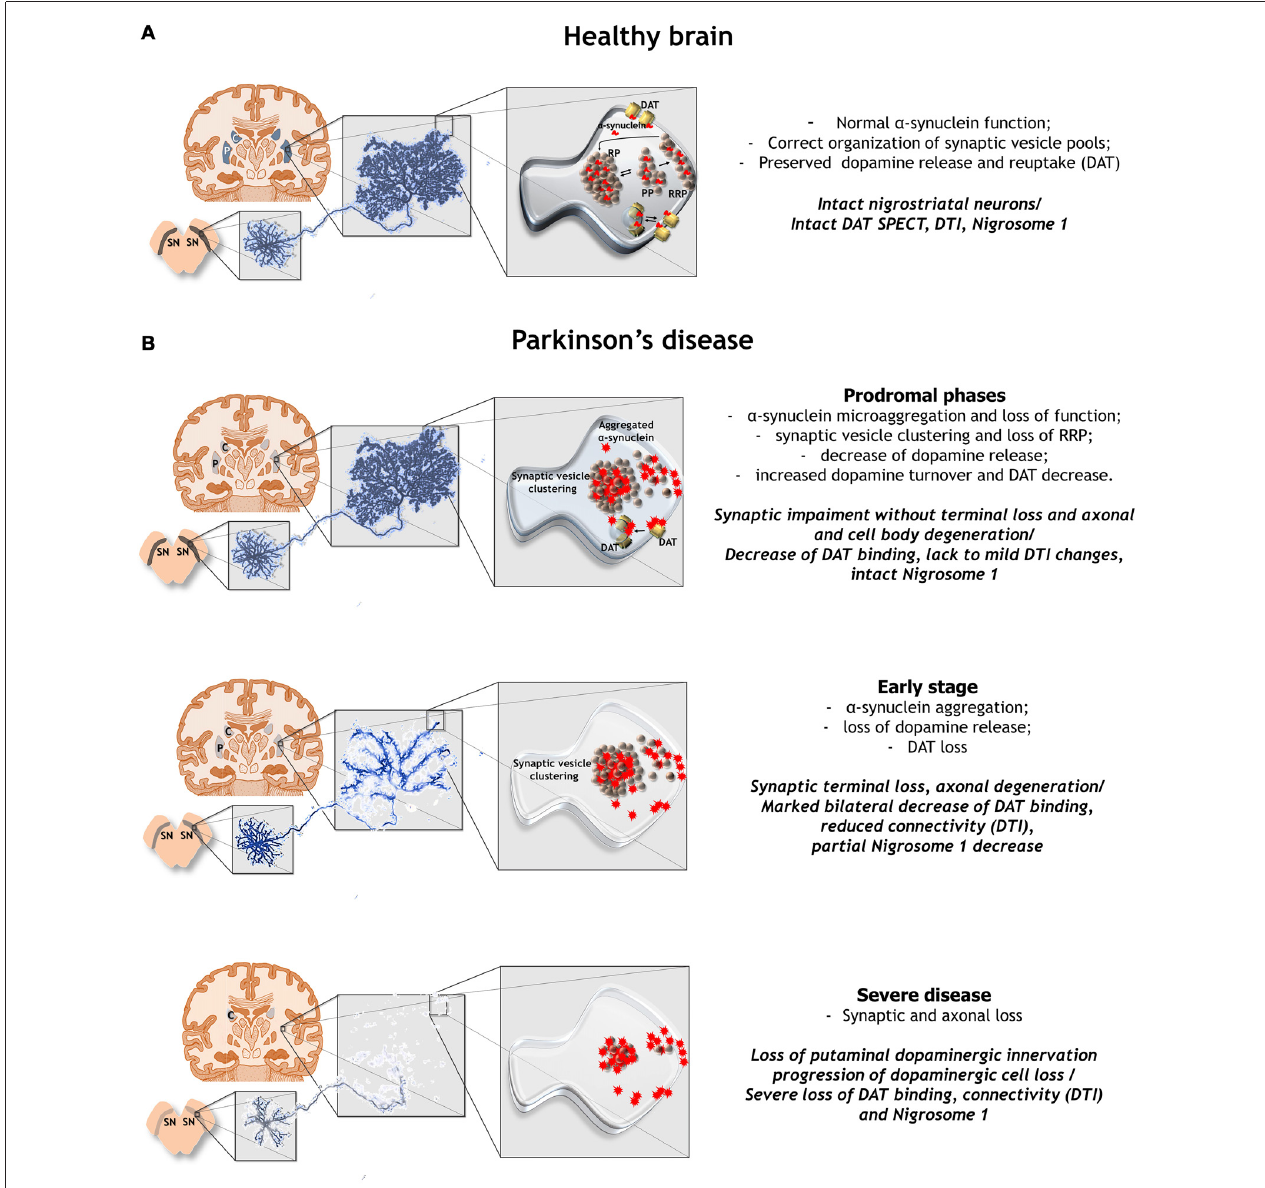
FIGURE 1 | The putative organization of the dopaminergic synapse in healthy condition and in Parkinson’s disease (PD) is presented in relation with nigrostriatal neuron degeneration, connectome function and the disease staging. (A) Correct organization of synaptic vesicle pools in a dopaminergic striatal terminal in the healthy brain. (B) Retrograde synapse-to-cell-body degeneration initiating and perpetrating nigrostriatal connectome dysfunction in PD. In the prodromal phases of PD, microaggregation of α -synuclein at synaptic terminals progressively changes the organization of synaptic vesicle pools, reduces dopamine release, alters dopamine turnover and decreases dopamine transporter (DAT) membrane content but nigral neuron loss is negligible. Alpha-synuclein can also spread from terminals. DAT binding is reduced with mild to absent alterations of diffusion tensor imaging (DTI) and lack of Nigrosome-1 decrease. This synaptic impairment may initiate connectome dysfunctions in the absence of marked synapse loss or axonal and cell body degeneration. In the early stages of PD, the onset of symptoms is related to the beginning of connectome deficits that mainly arise from synaptic and axonal loss and only to a lesser extent to nigral cell loss. DAT binding and DTI abnormalities are accompanied by a partial or unilateral decrease of Nigrosome-1. Finally, in the advanced phases of the disease, broad synaptic, axonal and cell body degeneration that can be detected by integrating multiple imaging techniques, concomitantly participate to disease progression. PP, Proximal pool; RRP, ready releasable pool, RP, reserve